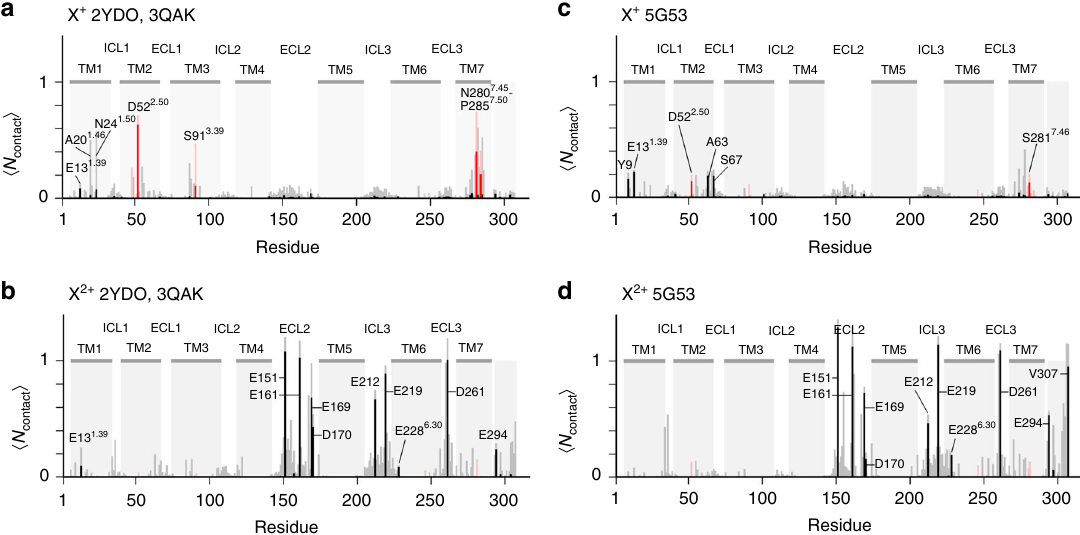
Fig. 6 Cation interactions with A 2A R. Histograms show the proportion of ions within 0.6 nm (light bars) or 0.3 nm (dark bars) of any receptor atom, N h i , as a function of residue number averaged over ( a , b ) fi ve 1- μ s simulations from each of two agonist-bound A contact 2YDO and 3QAK], and ( c , d ) fi ve 1- μ s simulations from the agonist and G-protein-bound A 2A R crystal structure [PDB ID: 5G53]. Contacts are shown for monovalent ( a , c ) and divalent cations ( b , d ). Note that red bars designate residues known to coordinate Na + in the inactive state. Transmembrane (TM) helices, intracellular loops (ICL), and extracellular loops (ECL) are